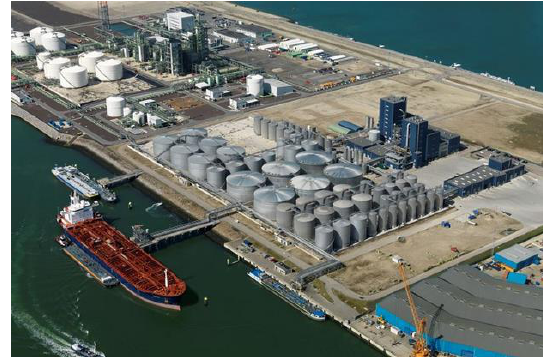
Fig.10. Neste refinery plant in Rotterdam